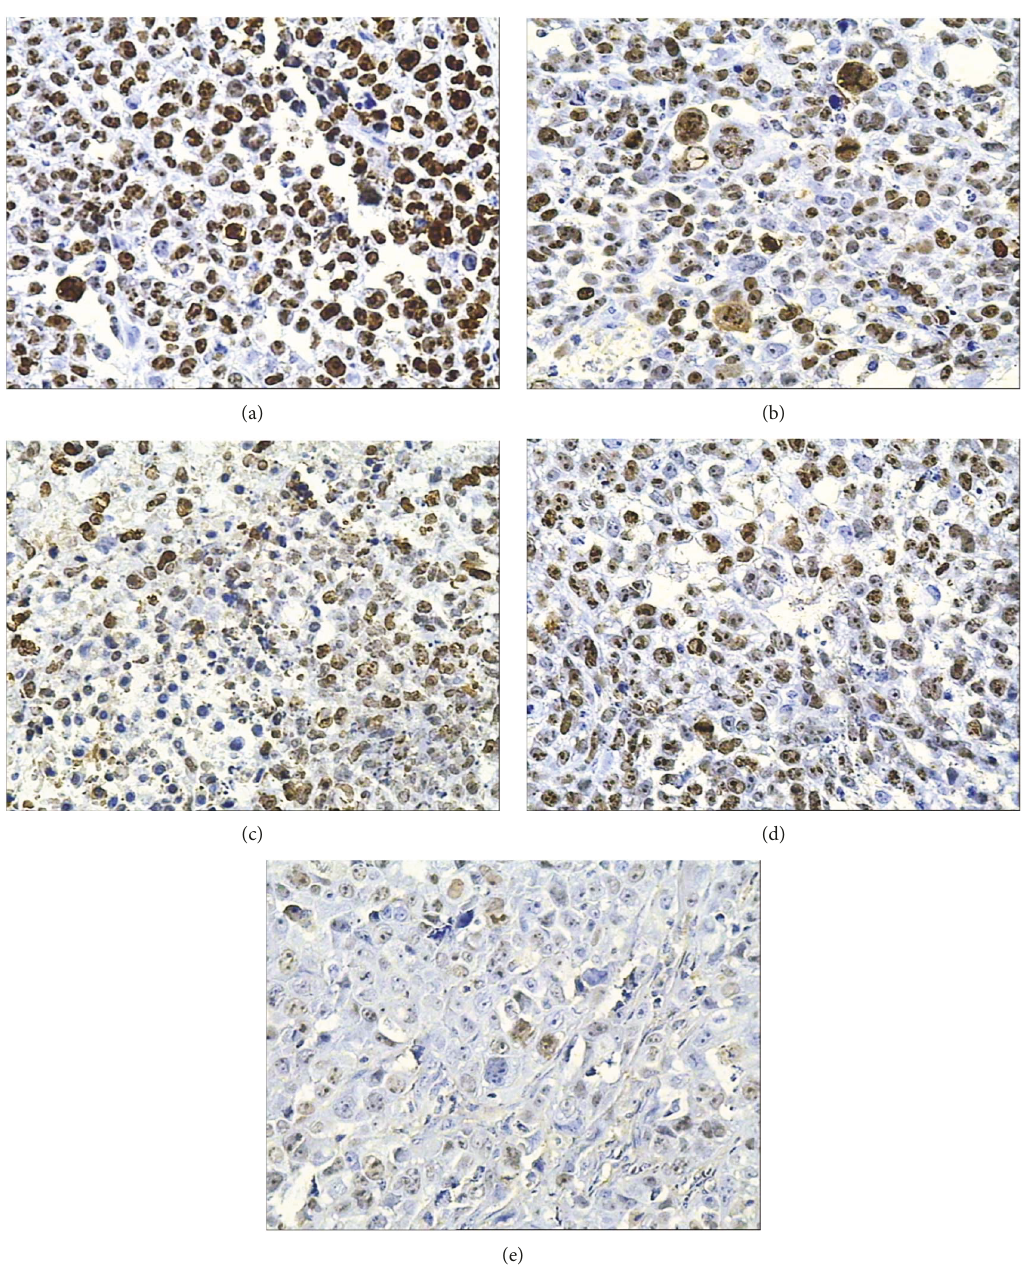
Figure 6: Ki67 protein expression in hepatoma tissues after di ff erent treatments tested by IHC (200x). (a) Saline control group. (b) Radionuclide group. (c) Radionuclide-gene group. (d) MFH group. (e) Radionuclide-gene-MFH group. Table 6: Ki67 protein expression of hepatoma tissues after di ff erent treatments tested by IHC (mean ± s, n = 5 ). Group Saline group Radionuclide group Radionuclide-gene group MFH group Radionuclide-gene-MFH group Positive percent (%) 79.02 ± 3.58 bcde Positive index a p < 0 05 versus saline group; b p < 0 05 versus radionuclide group; c p < 0 05 versus radionuclide-gene group; d p < 0 05 versus MFH group; e p < 0 05 versus radionuclide-gene-MFH